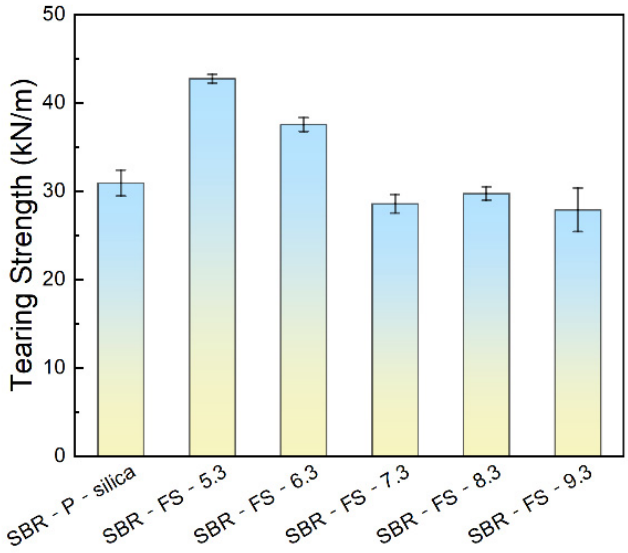
Figure 6. Tearing strength of the SBR rubber filled with P-silica and FS-SiO 2 .